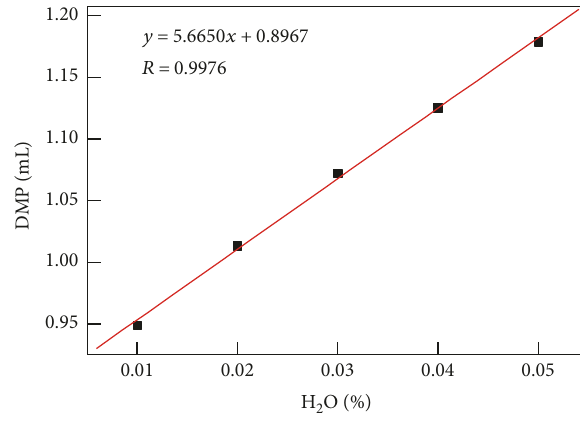
Figure 1: Calibration curve of the DMP. Table 5: Results of jet fuels with di ff erent standard water contents. Spiked water content (%) 0.01